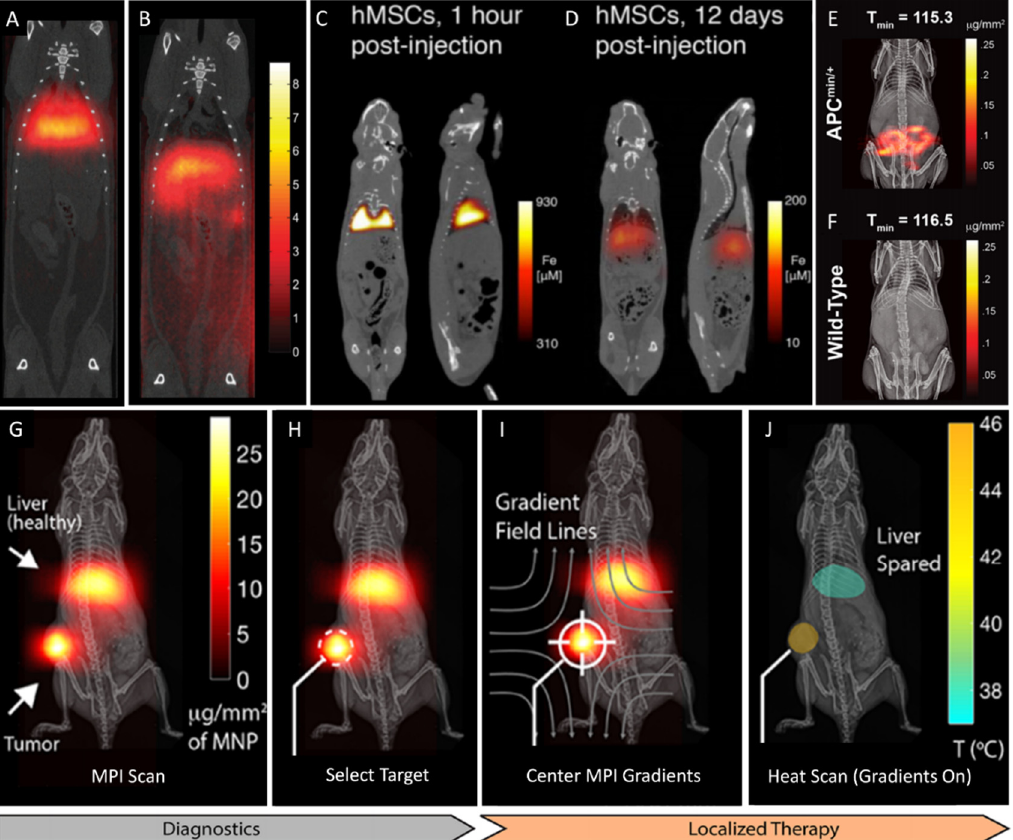
Figure 6. MPI of intravenously administered ( A ) MAA-SPION and ( B ) SPION in healthy rats. The larger MAA-SPION target the lungs while smaller SPION distribute primarily to the liver. MPI of tracer labeled human MSCs ( C ) 1 h and ( D ) 12 days after intravenous administration in healthy rats. Labeled MSCs move from the lungs to the liver and spleen over the course of 12 days. The subtraction MPI of ( E ) GI polyp/bleed and ( F ) normal mouse models about 2 h post intravenous administration. Signal evident in the intestines for mice with GI bleed. ( G – J ) Procedure for MPI-guided localization and magnetic hyperthermia therapy. The diagnostic stage involves ( G ) the initial MPI scan of the tumor-bearing mouse model and ( H ) selecting the target. The localized therapy stage involves ( I ) centering the FFR on the target followed by ( J ) the therapeutic heat scan. ( A , B ) Reproduced with permission from Zhou, X. Y. et al., Physics in Medicine & Biology; published by Institute of Physics and Engineering in Medicince, 2017. ( C , D ) Reproduced with permission from Zheng, B. et al., Theranostics; published by Ivyspring International Publisher, 2016. ( E , F ) Reproduced with permission from Yu, E. Y., et al., ACS Nano; American Chemical Society, 2017. ( G – J ) Reproduced with permission from Tay, Z. W., et al., Nano Letters; published by American Chemical Society, 2018.